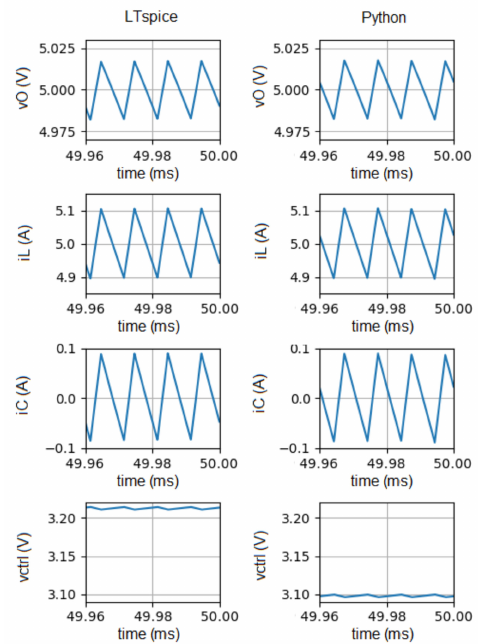
Figure 11. Waveforms of v O , i L , i C and v ctrl obtained in steady-state regime, with LTspice ( left plots ) and with the proposed simulation technique ( right plots